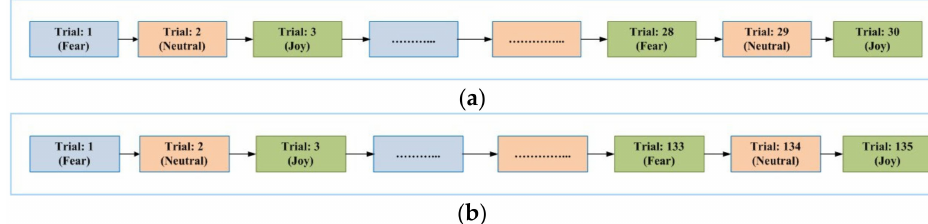
Figure 1. ( a ) Sequence of trials with respect to the emotional states in EI and VI paradigms. ( b ) Sequence of trials with respect to the emotional states in PI and SI paradigms.